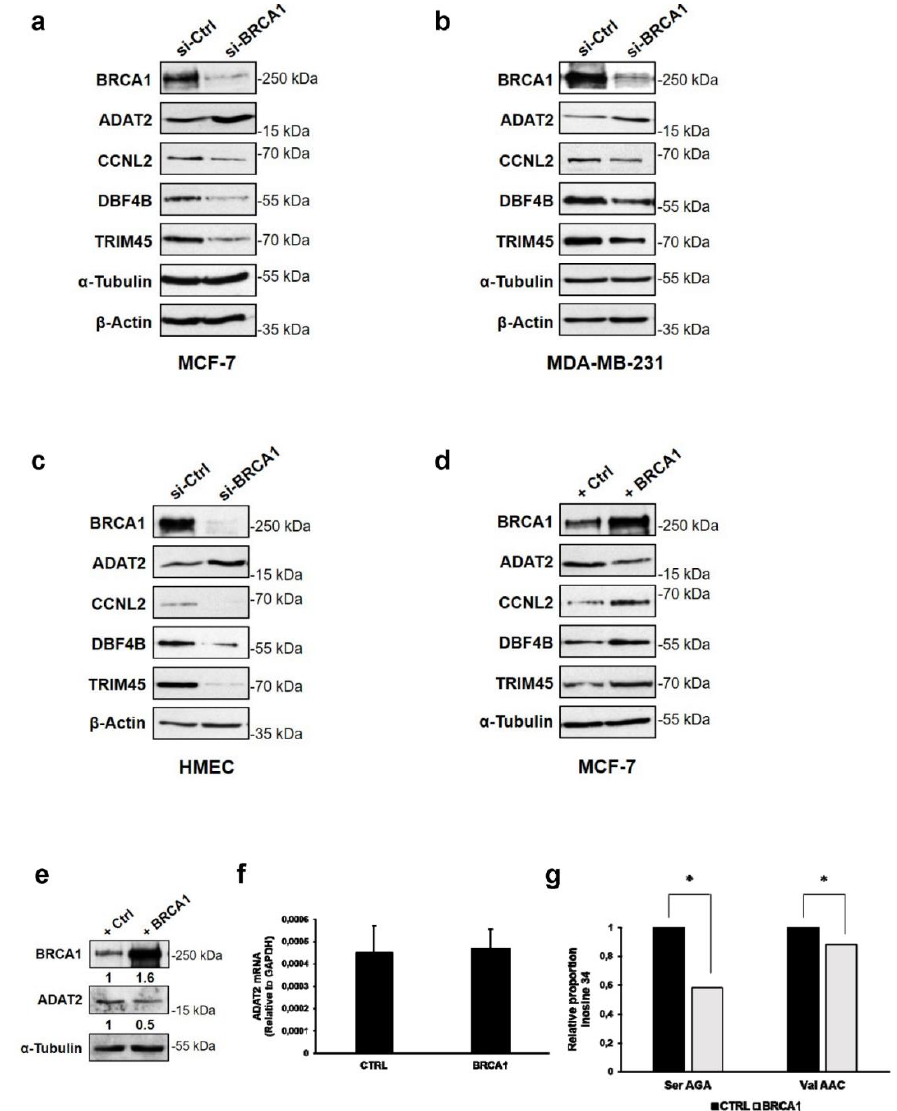
Figure 4. BRCA1 controls ADAT2, CCNL2, DBF4B, and TRIM45 proteins in mammary epithelial cell lines. ( a – c ) Immunoblot analyses of ADAT2, CCNL2, DBF4B, and TRIM45 proteins from MCF-7 cells ( a ), MDA-MB-231 cells ( b ), and HMECs ( c ) transfected with BRCA1-targeting siRNA (si-BRCA1) or